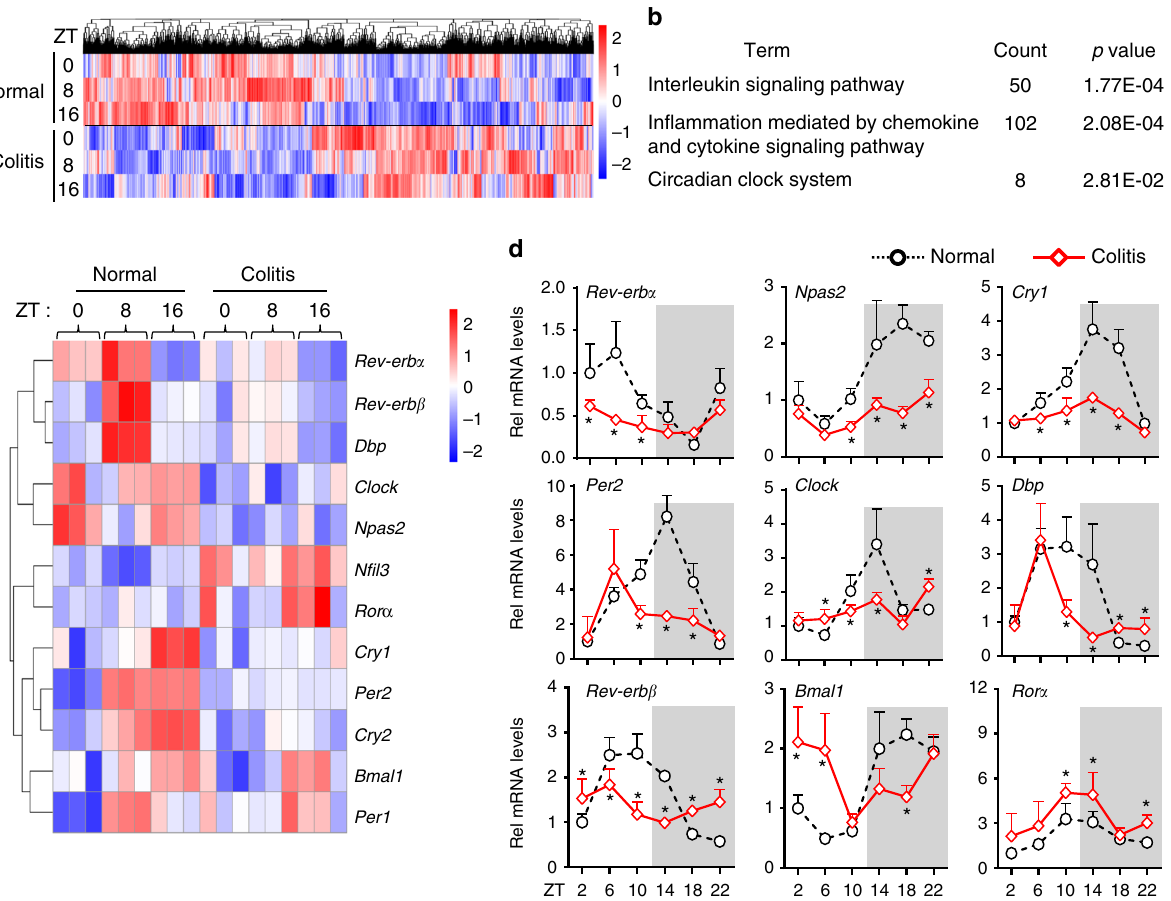
Fig. 1 Circadian clock is dysregulated in mice with DSS-induced colitis. a Hierarchical clustering heatmap, comparing gene expressions in the colon between DSS-treated and control mice. Each column represents a gene and each row represents colon samples from different time points. Red indicates high relative expression and blue indicates low expression of genes as shown in the scale bar. b PANTHER pathway analysis results of differentially expressed genes (DEGs). c Heatmap of relative expressions of core clock genes in the colon. d qPCR assays of the core clock genes in DSS-treated and control mice. Data are presented as mean ± SD ( n = 5). * P < 0.05 versus normal mice at individual time points ( t